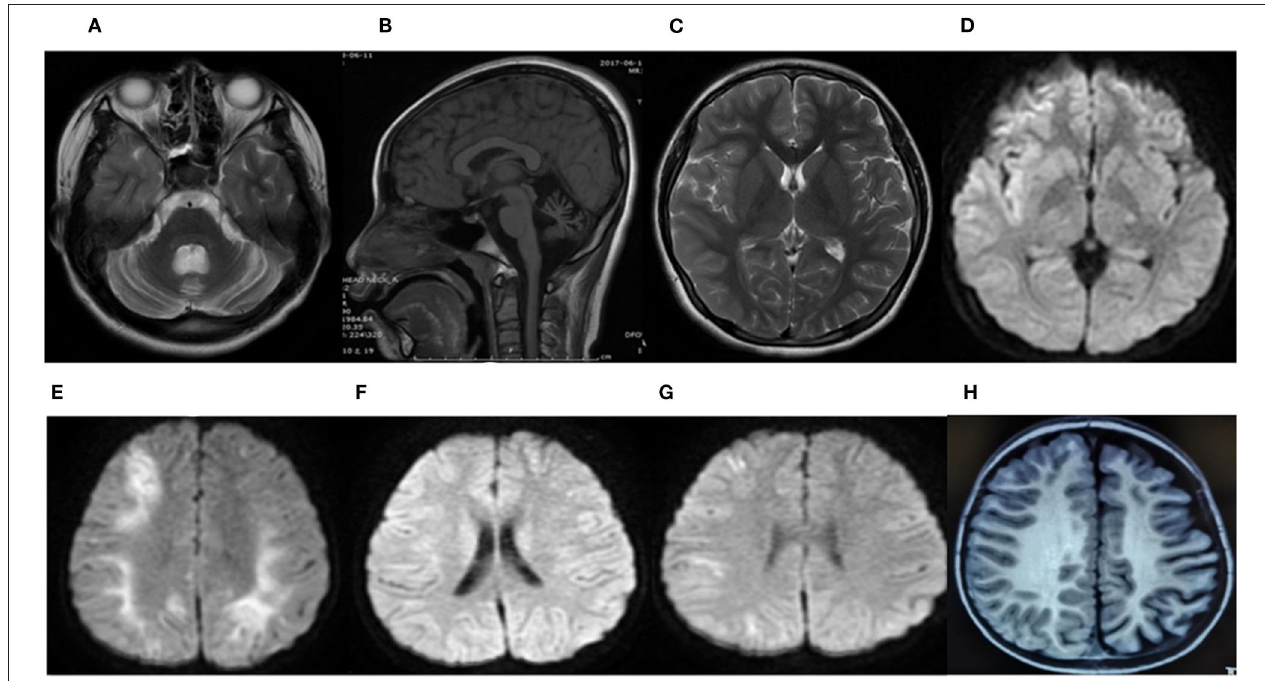
FIGURE 2 | Brain MRI of patient 1 during the last attack at age 13 years (A–D) . An axial T2-weighted image (T2W) (A) and a sagittal T1-weighted image (T1W) (B) showed severe cerebellar atrophy. An axial T2-weighted image (T2W) (C) and an axial diffusion-weighted image (DWI) (D) showed a slight hyperintense signal in the frontal, temporal, and occipital region of the right hemisphere. The brain MRI of patient 3 (E–G) . The axial diffusion-weighted image (DWI) at age 3 during a severe attack (E) , 1 year later (F) , and at 6 years old soon after the last episode (G) . (E) Revealed restricted diffusion in the bilateral hemisphere. (F) Demonstrated a complete resolution of the cortical lesion. (G) Showed a mild restricted diffusion in the right hemisphere. The brain MRI of patient 6 at 22 months of age (H) . An axial T1-weighted image (T1W) showed significant atrophy of the left hemisphere.